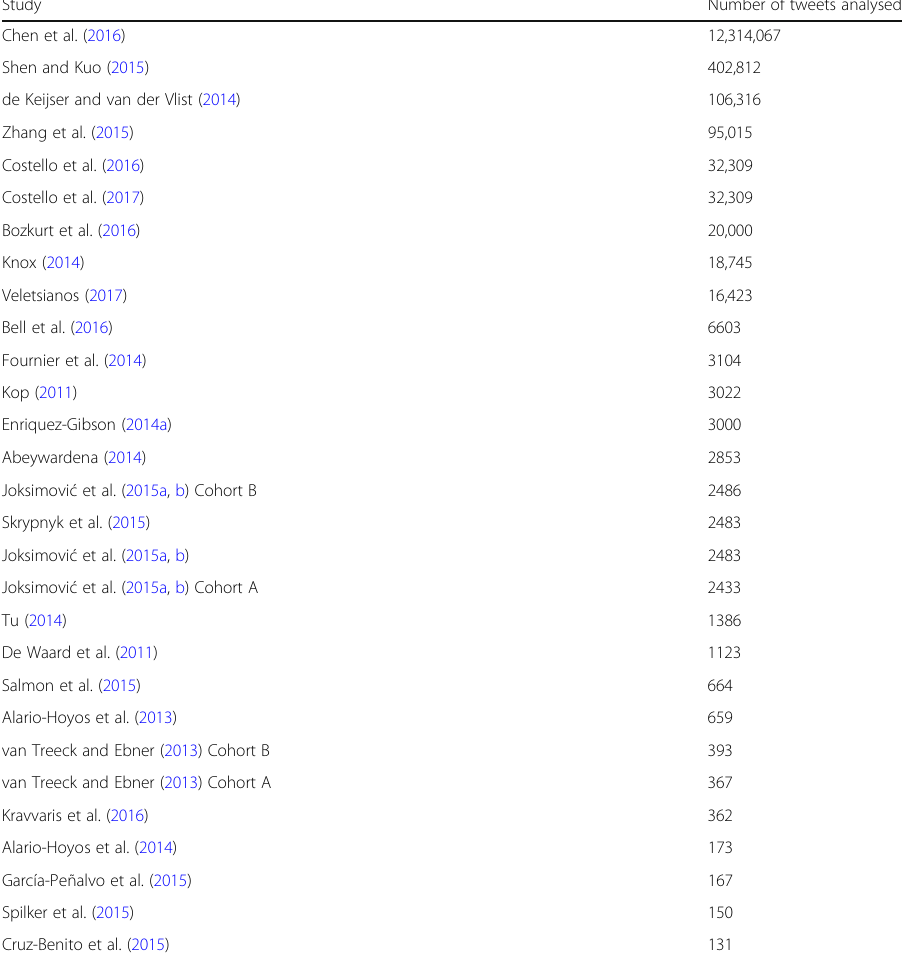
Table 6 Number of Tweets